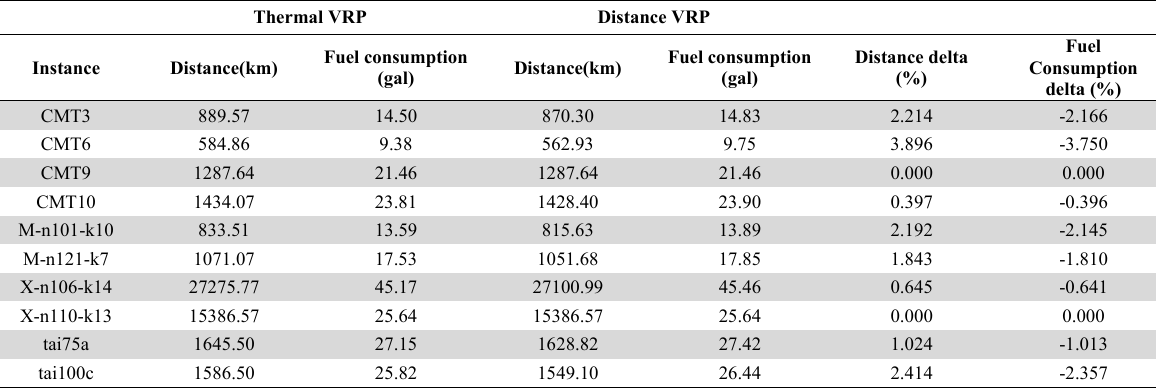
Comparison Thermal VRP and Distance